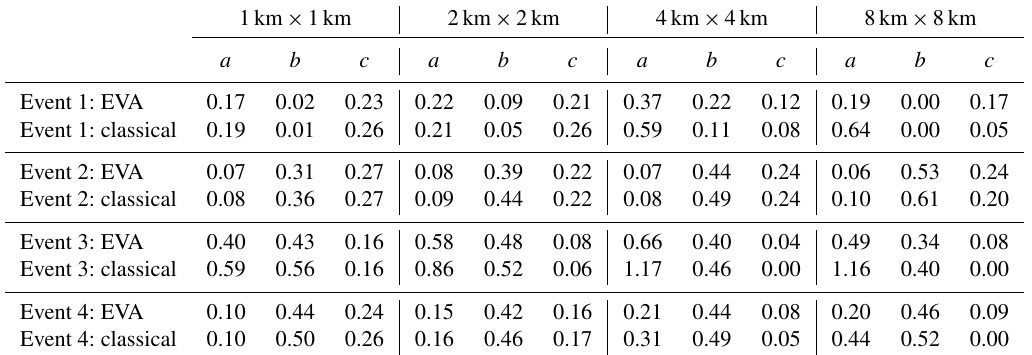
Table 2. Model parameter estimates a , b and c for the first four events for input resolutions of 1km × 1km, 2km × 2km, 4km × 4km, and 8km ×